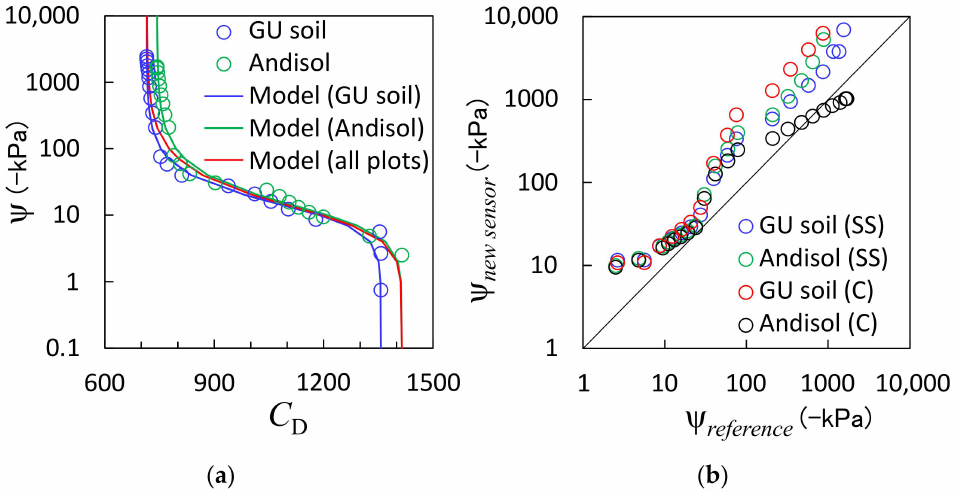
Figure 4. ( a ) Relationship between the soil matric potential ( ψ ) and the C D measured using the reference and proposed sensors, respectively, and ( b ) comparison between the ψ measured with the reference sensor ( ψ reference ) and the proposed sensor ( ψ new sensor ). The different colored plots in panel ( a ) represent the Gifu University experimental field soil (GU soil) and the Andisol, and the solid lines indicate fitted models (Equation (4)) with the plots of either soil and with all plots. The different colored plots in panel ( b ) represent the GU soil and the Andisol with the sensor-specific (SS) or common (C) parameters of Equation